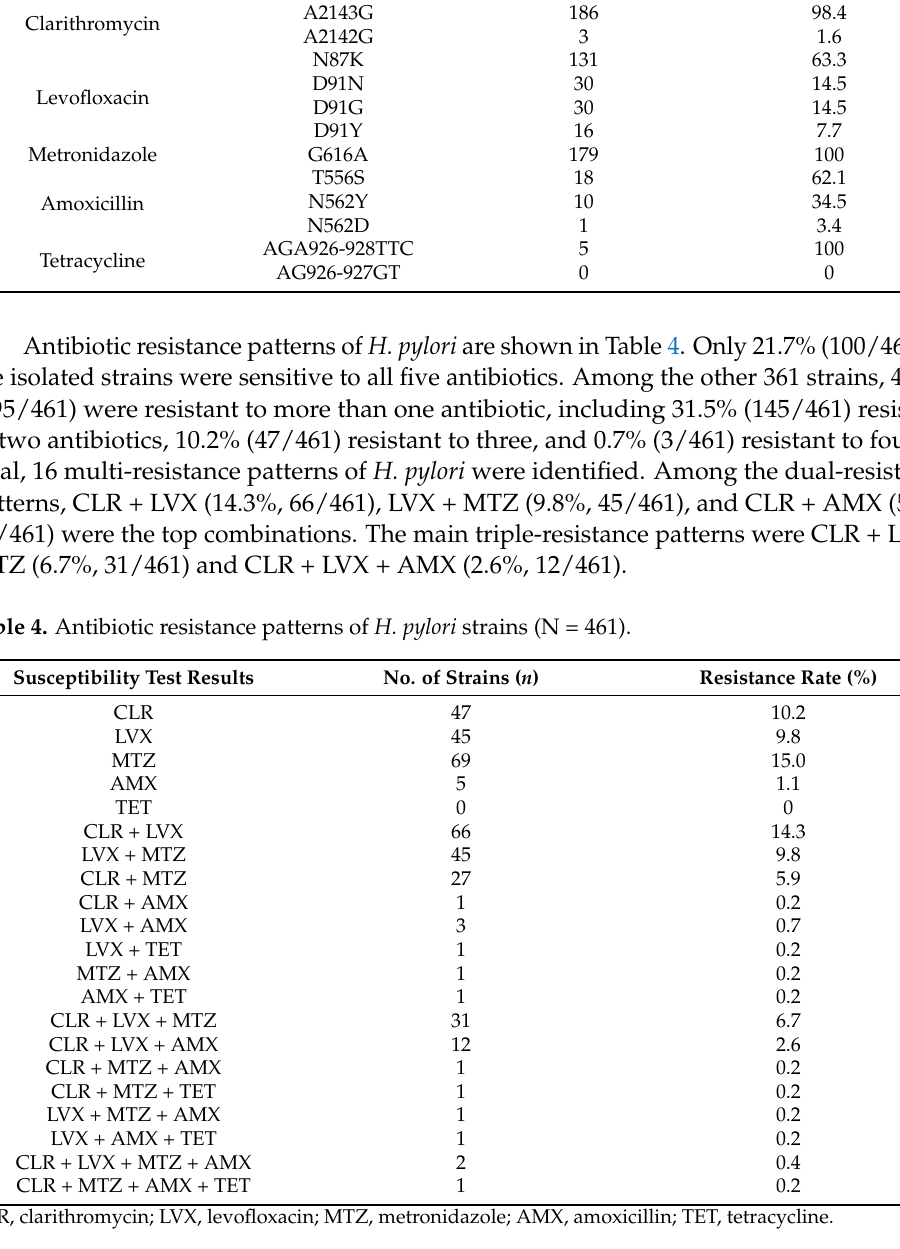
Table 3. Detection of H. pylori resistant gene locus by gene chip technology. Antibiotics